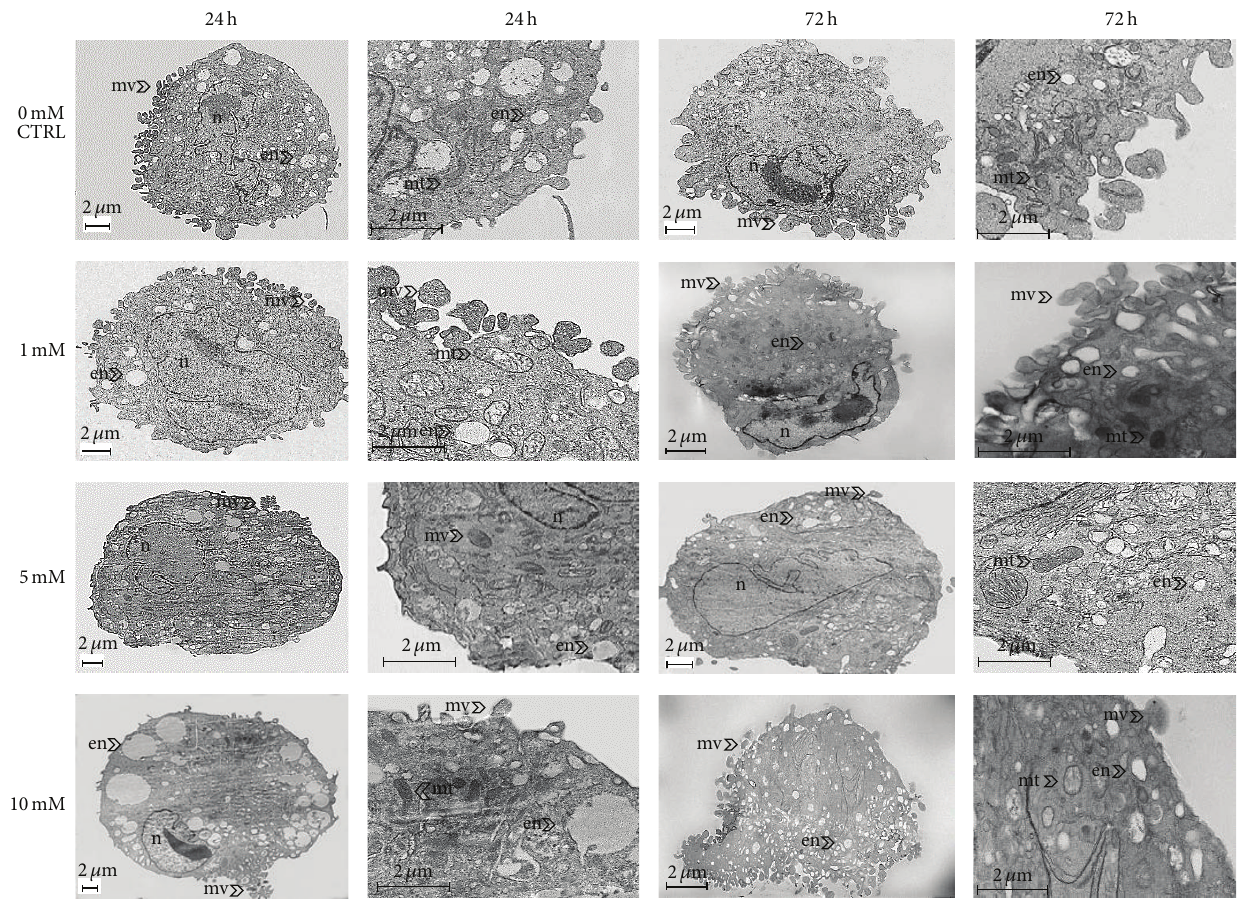
Figure 7: The ultrastructural changes of mice ASCs after 24 and 72 hours in the cultures treated with 1mM, 5 mM, and 10 mM of metformin in comparison to the control culture. Typical ultrastructural features were indicated with proper abbreviations: nu: nucleus, en: endosomes, mv: microvesicles, and mt: mitochondria. Depicted images are representative, and were obtained from cultures carried out in